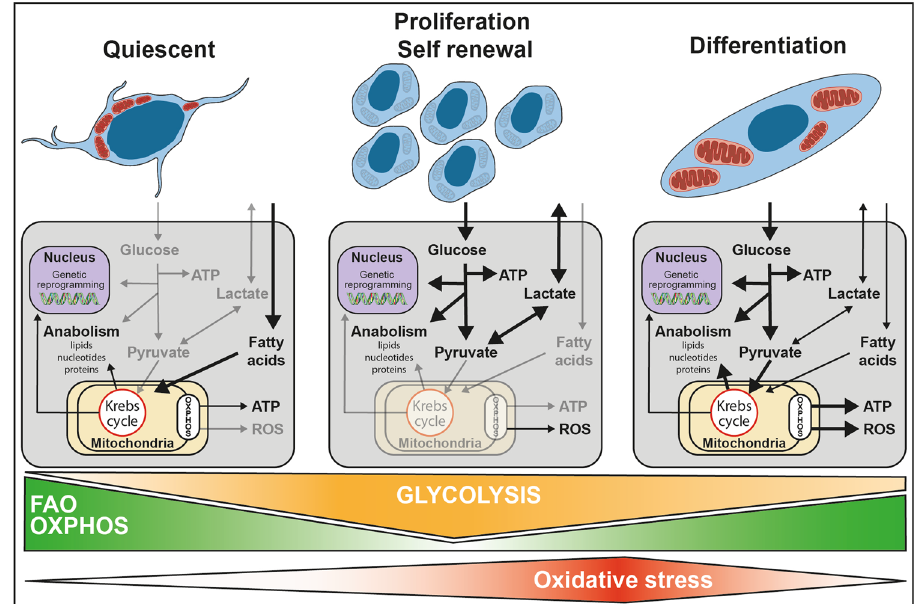
Fig. 3 Proposed metabolic pathways regulating quiescence, self-renewal, and differentiation during myogenesis. The low metabolism of quiescent MuSCs is mostly dependent on mitochondrial fatty acid oxidation and oxidative phosphorylation. This promotes epigenetic modi fi cation that represses myogenic transcription programs. MuSC activation is associated with a shift toward anaerobic glycolysis. This supports a metabolic environment that allows for rapid biosynthesis, therefore, supporting MuSC growth and proliferation. An increase in mitochondrial respiration precedes MuSC differentiation. This elevated dependence on oxidative phosphorylation triggers a burst of ROS that act as secondary messengers to strengthen